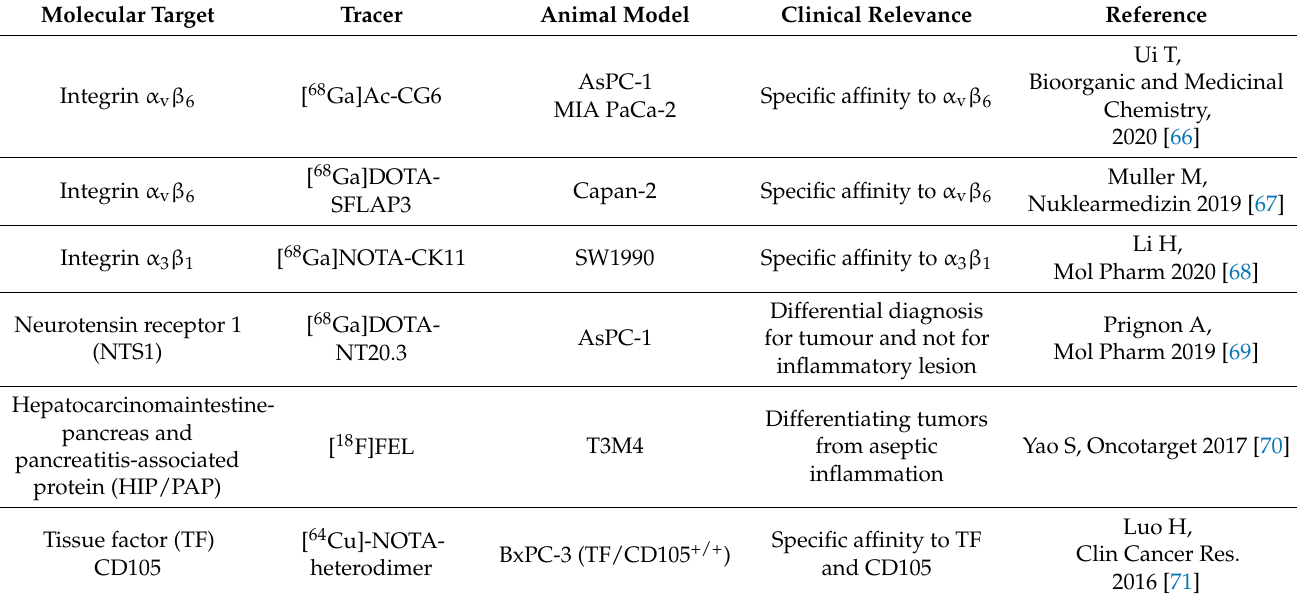
Table 2. List of PET tracers (and targets) investigated in animal models of